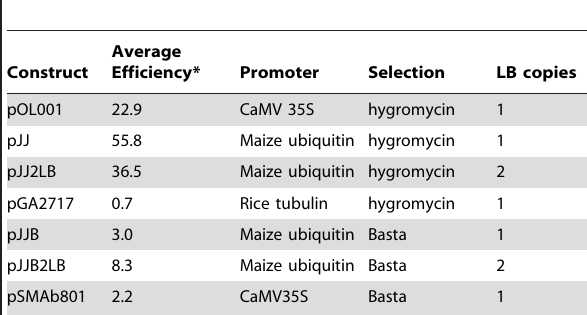
Table 2. Sequences and locations of primers used for Inverse PCR.